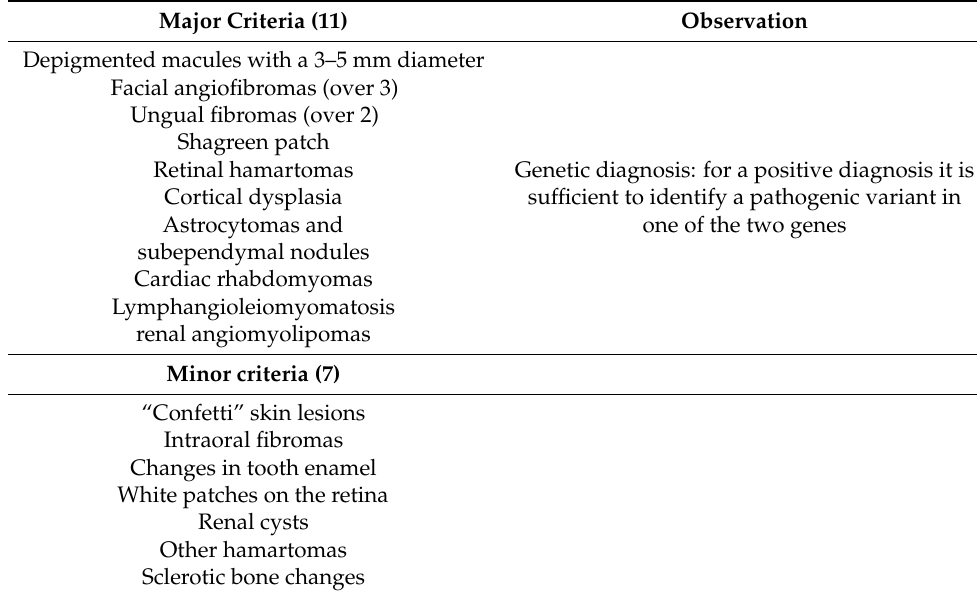
Table 2. Criteria for a positive tuberous sclerosis